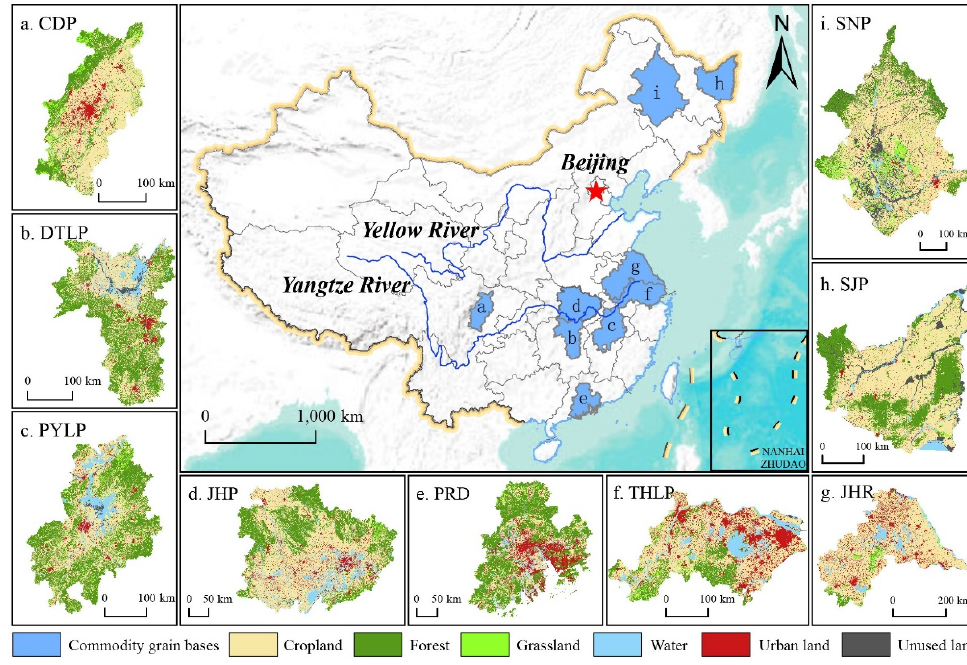
Figure 1. Study area ( a – i ) denote Chengdu Plain, Dongting Lake Plain, Poyang Lake Plain, Jianghan Plain, Pearl River Delta, Taihu Lake Plain, Jianghuai Region, Sanjiang Plain, Songnen Plain).